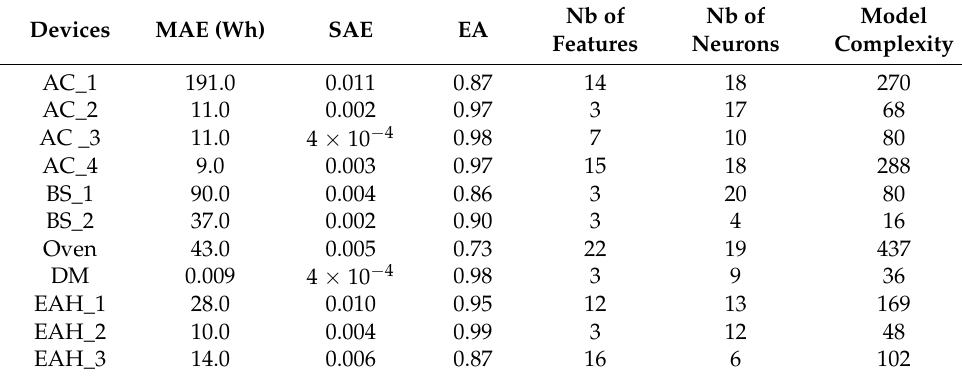
Table 24. Energy estimation